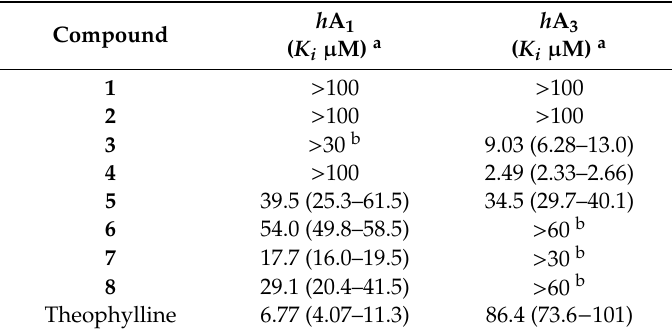
Table 1. Binding a ffi nity ( K i ) of compounds 1 – 8 on h A 1 and h A 3 AR.